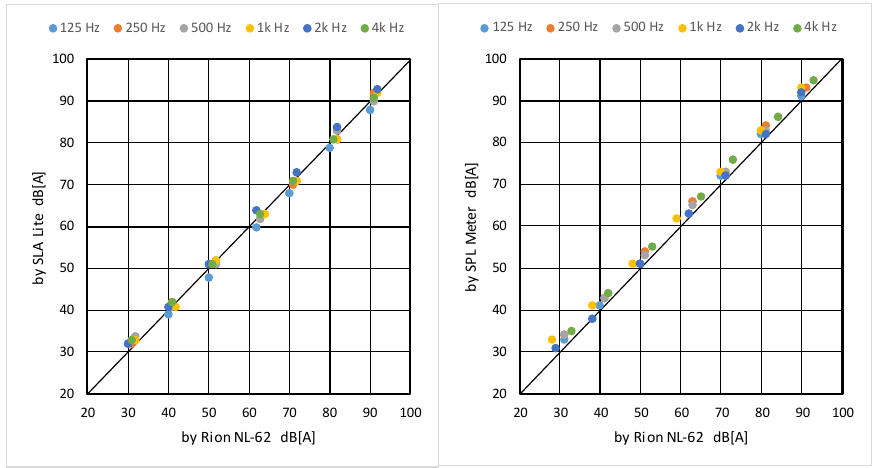
Figure 6. Results of accuracy test of SPL (A-weighted) by measuring applications on iPhone 8 (model MQ842J/A, released September 2017). SLA Lite (left) and SPL Meter (right) compared with a class 1 SLM.